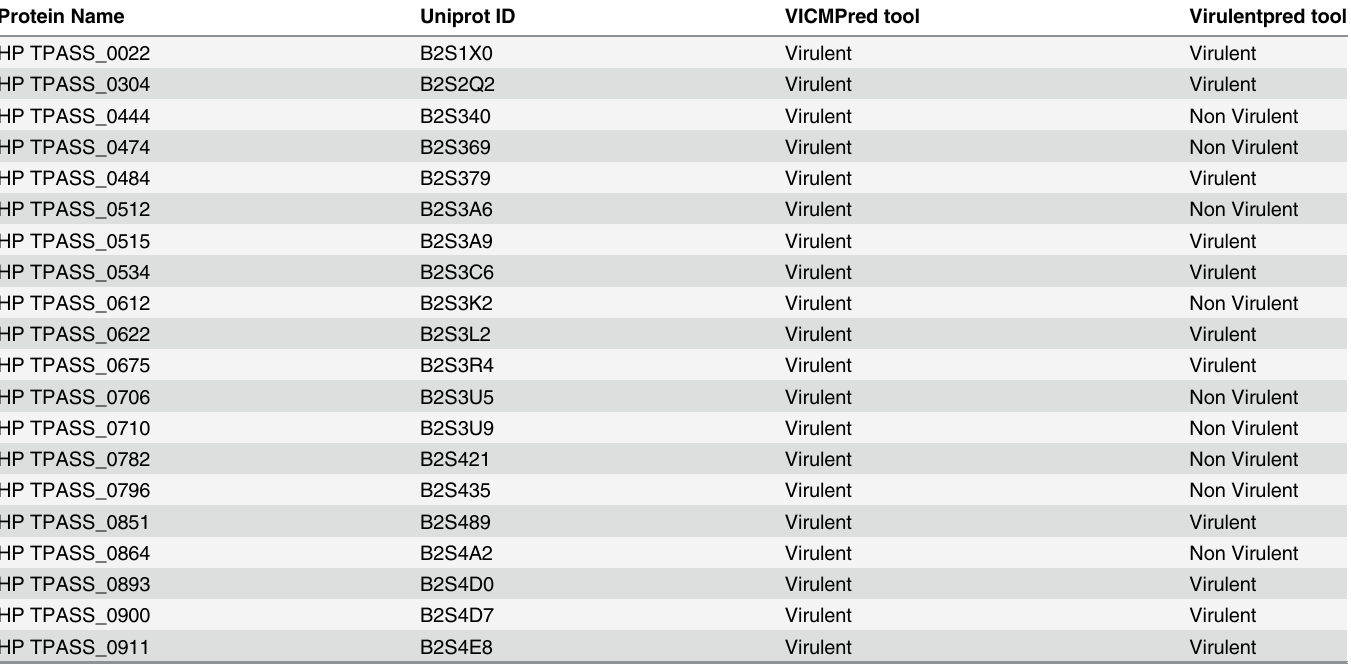
Table 2. List of HPs with virulence factors in T . pallidum ssp . pallidum